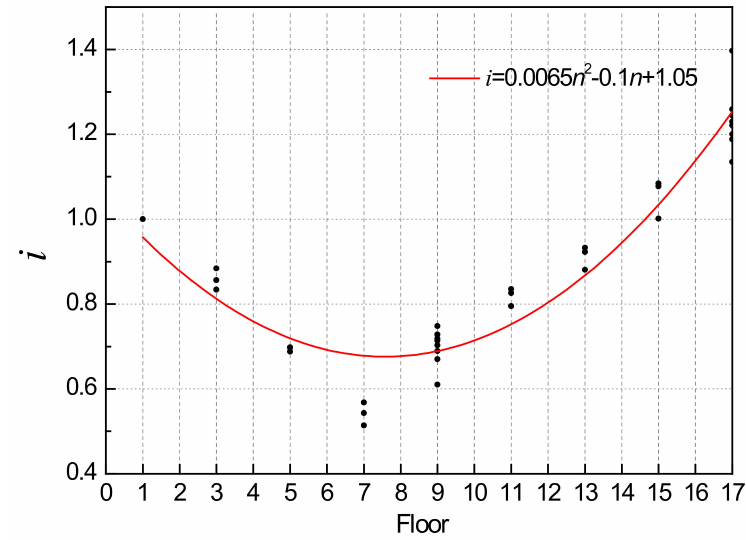
Figure 10. Fitting curve of floor n to ratio i